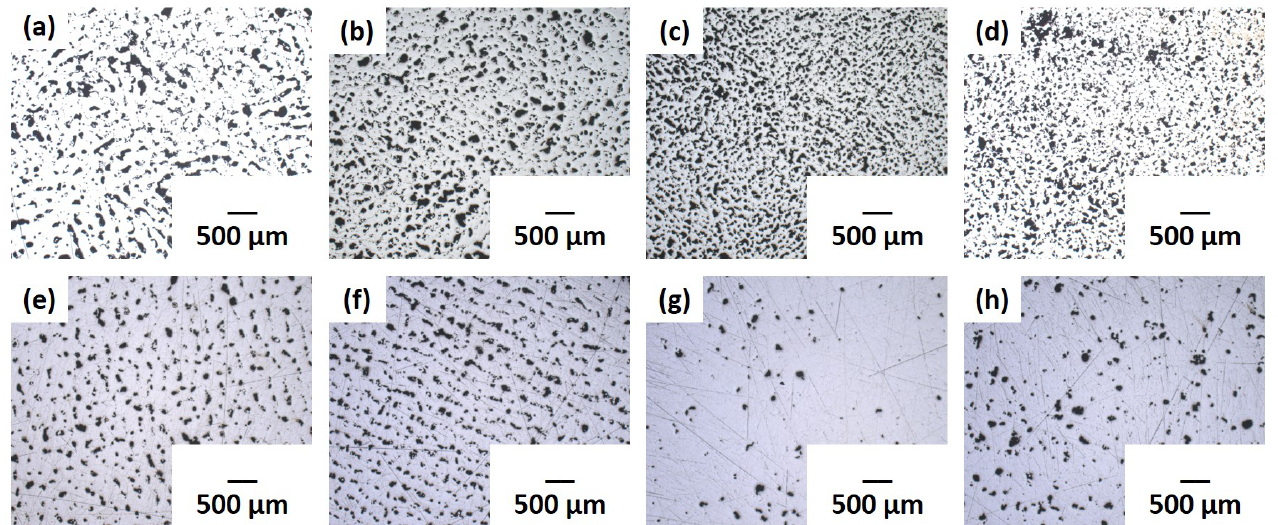
Figure 3. Optical images of bulk surfaces showing the porosity of both materials at all four scan speeds: ( a – d ) Pure molybdenum printed at 100, 200, 400, and 800 mm/s, respectively; ( e – h ) Mo-0.1SiC printed at 100, 200, 400, and 800 mm/s, respectively.